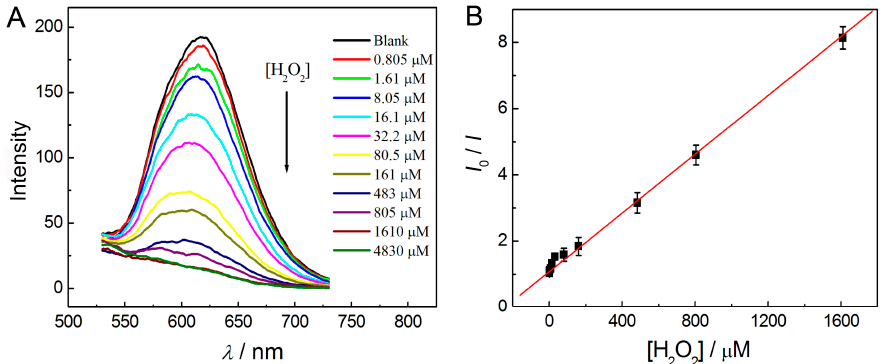
Figure 7. Quantificational detection of H 2 O 2 in solution phase using the as-prepared AuNCs as a luminescent probe: ( A ) luminescence quenching of the AuNCs with the addition of different amounts